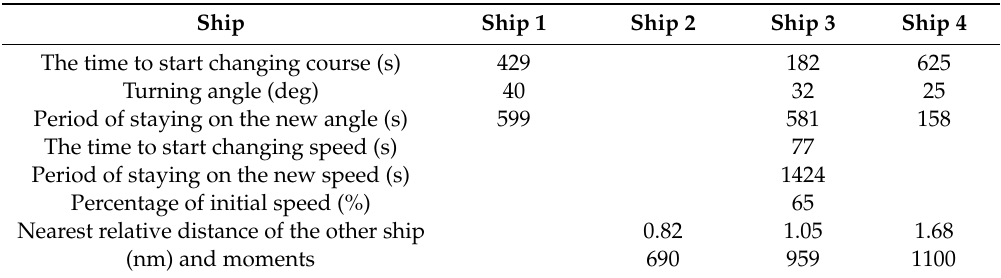
Table 3. Actions taken by each ship under scenario